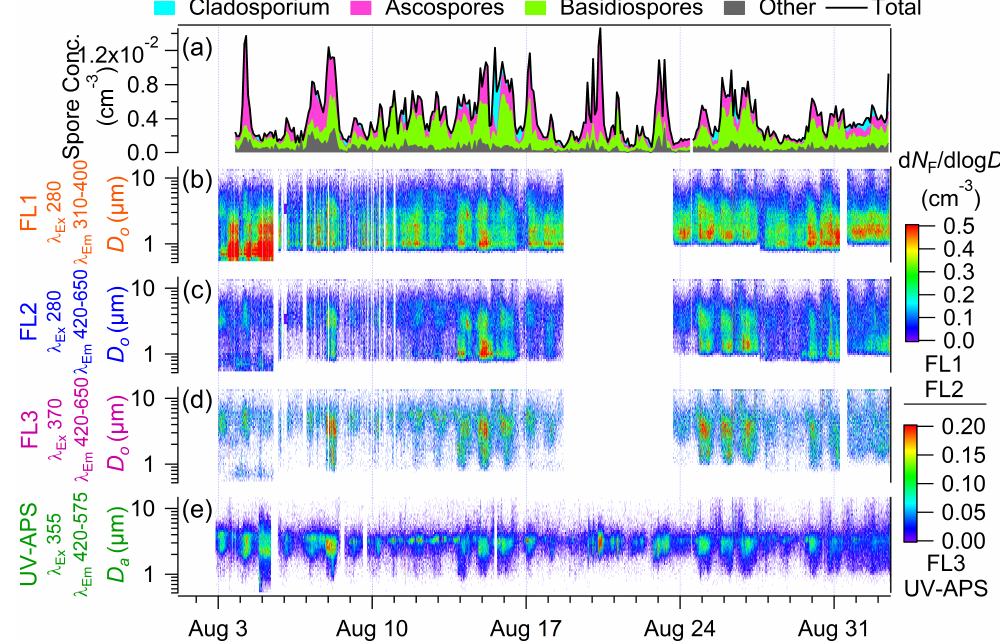
Figure 2. Campaign overview time series. Selected biological particles identified by Sporewatch technique (a) . Size-resolved measurements of fluorescent particles as determined by WIBS FL1 (b) , FL2 (c) , and FL3 (d) channels, and UV-APS (e) . Color scale for image plots (b–e) shown as d N F /dlog D (cm − 3 ) on the right and is separated into FL1, FL2 (upper scale) and FL3, UVAPS (lower scale). Data reported for both WIBS-4 and UV-APS as 5min averages and for Sporewatch as 2h